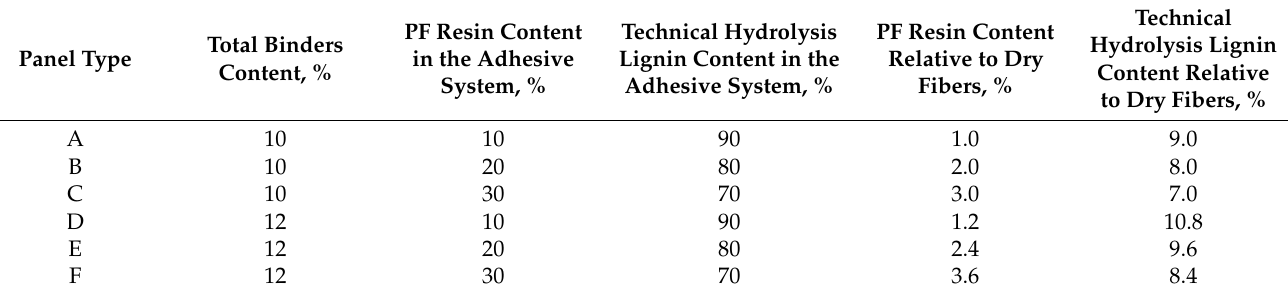
Table 1. Manufacturing parameters of laboratory-fabricated fiberboard panels bonded with adhesive systems composed of HL and PF